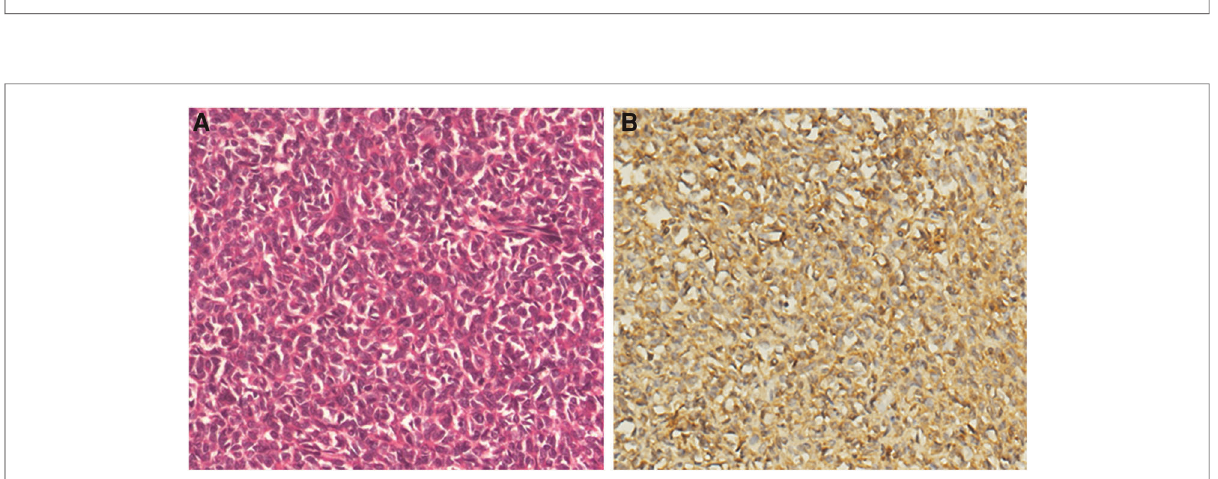
FIGURE 2 Pathological fi ndings of the surgically resected tumors. ( A ). Hematoxylin-eosin (HE) staining (×150). ( B ). Immunostaining for IGF-2 is diffuse positive